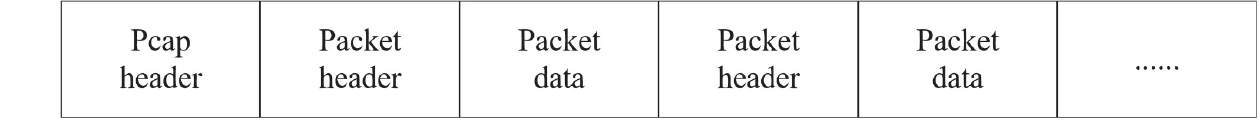
Fig 2. The structure of Pcap